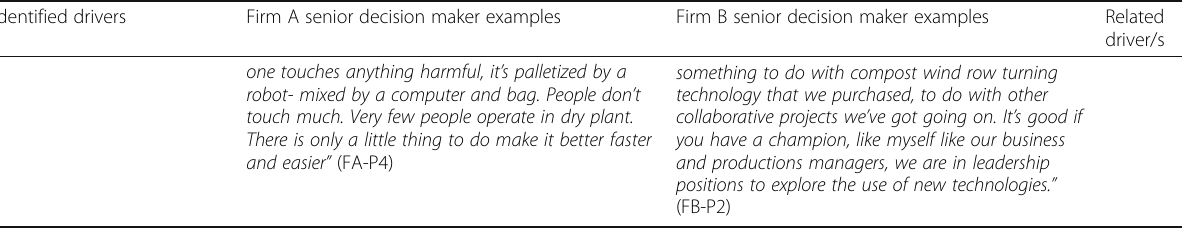
Table 3 Identified drivers and examples of sustainable business practice (Continued) Identified drivers